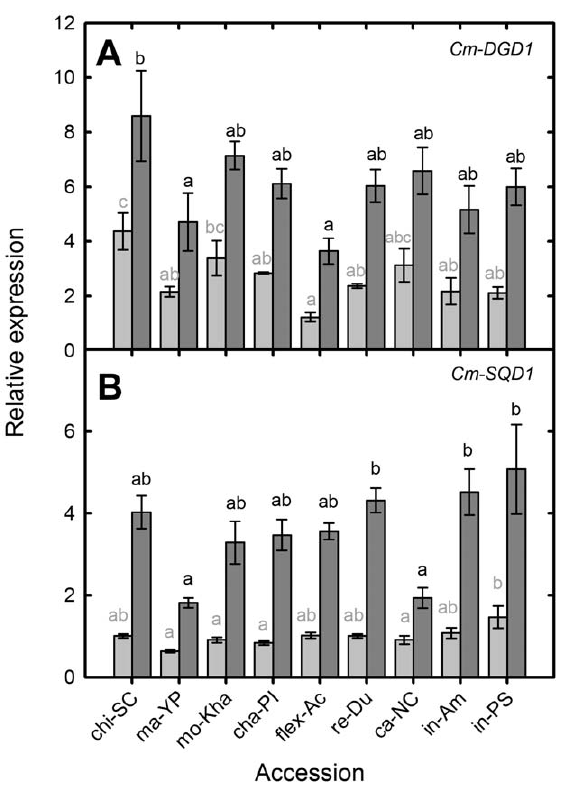
Figure 6. Relative root transcript abundance for Cm-DGD1 , (b) Cm-SQD1 in nine different melon accessions under P replete and P starved conditions. Relative transcript abundance for (a) Cm- DGD1 [MU51583], (b) Cm-SQD1 [MU52028] in different melon acces- sions grown hydroponically with a full nutrient solution (Control, light grey) or nutrient solution containing no phosphate (NoP, dark grey) for 21 d. Transcript abundance was measured using quantitative PCR (Q- PCR) and expressed relative to that of the housekeeping gene ( Cm- Ubiquitin ). Grey bars with the same grey letter are not significant different at P , 0.05 by Newmans Keuls multiple range test. Dark grey bars with the same letter are not significant different at P , 0.05 by Newmans Keuls multiple range